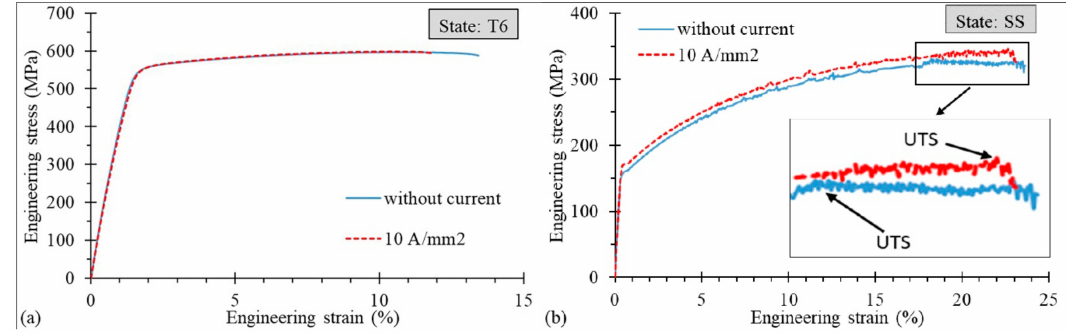
Figure 2. Engineering stress–strain curves for the AA7075-T6 ( a ) and SS ( b ) states.